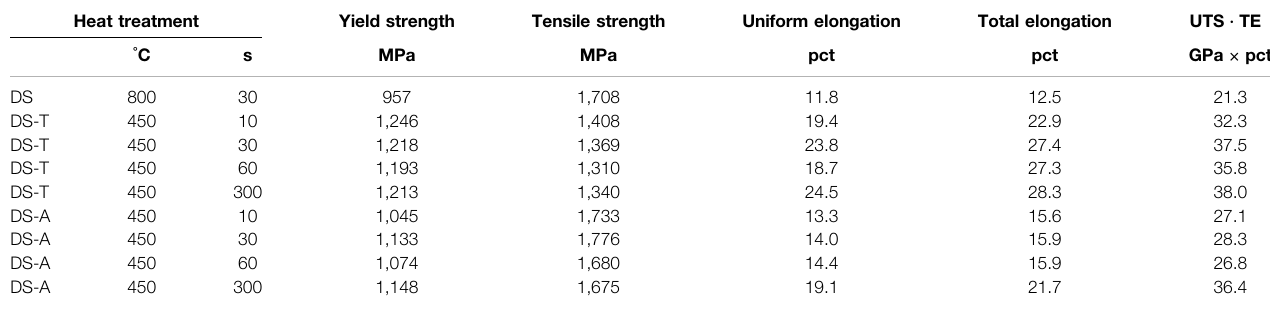
TABLE 1 | Tensile properties for the DS-T and DS-A medium manganese steels. Heat